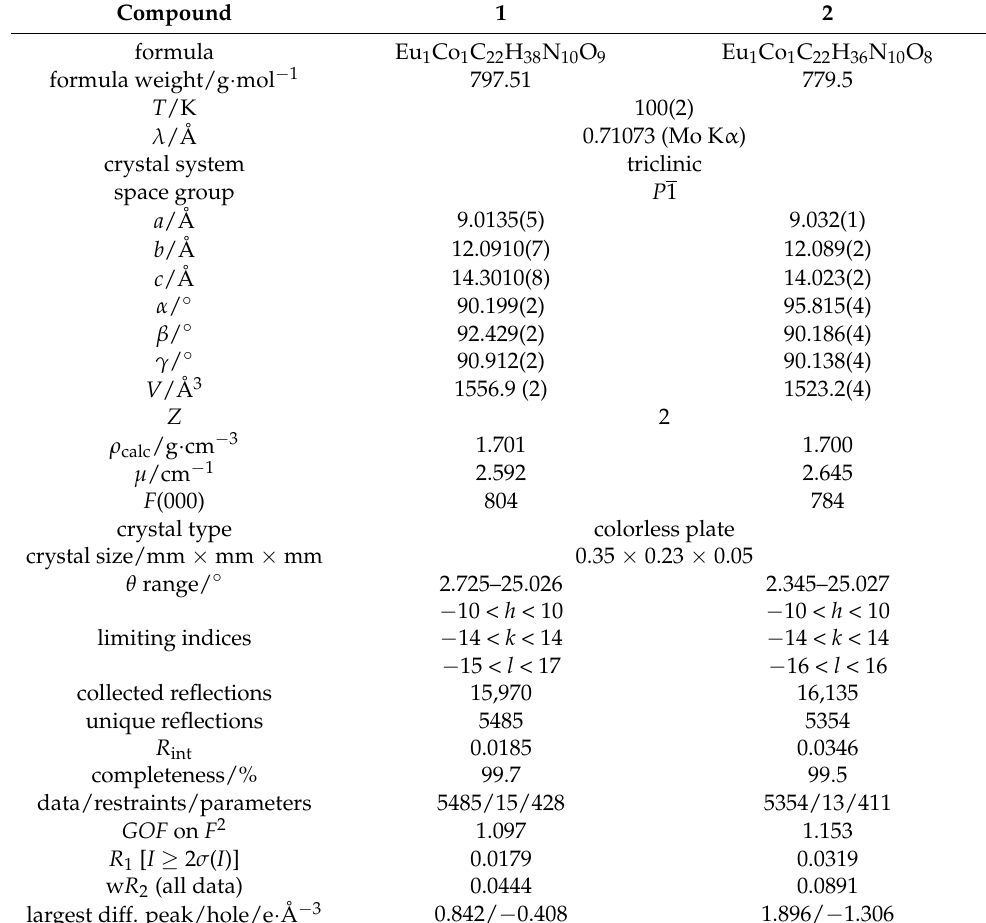
Table 1. Crystal data and structure refinement for 1 and 2